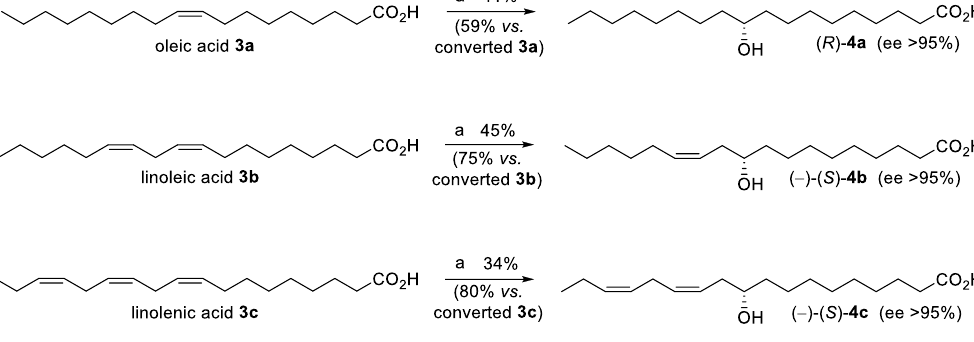
Figure 4. Transformation of 10-hydroxystearic, (12 Z )-10-hydroxy-octadecenoic and (12 Z ,15 Z )-10- hydroxy-octadecadienoic acids 4a – c to the corresponding derivatives 8a – c . Reagents and conditions: (a) CH 2 N 2 , Et 2 O, 0 °C; (b) Ac 2 O/Py, DMPA cat., RT.